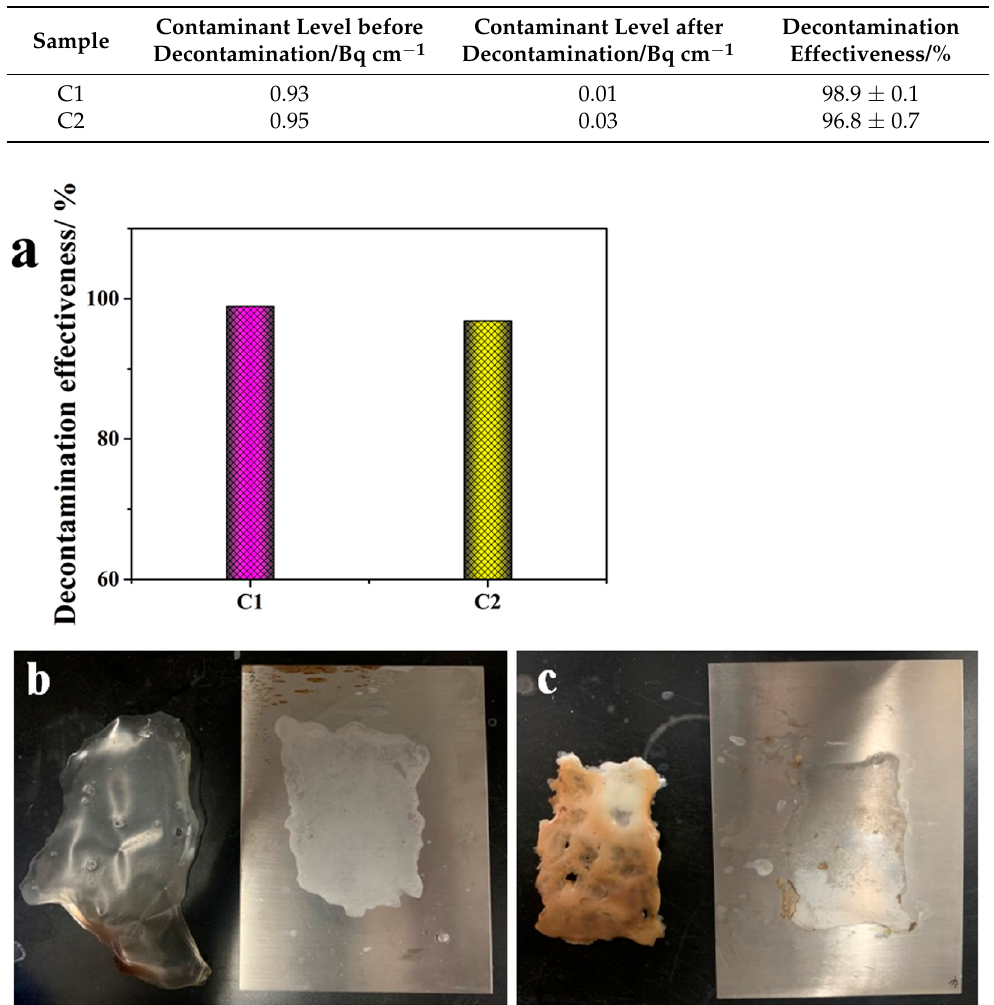
Figure 4. ( a ) Decontamination effectiveness and photographs of polymeric coating ( b ) C1 and ( c ) C2 for stainless steel plates.